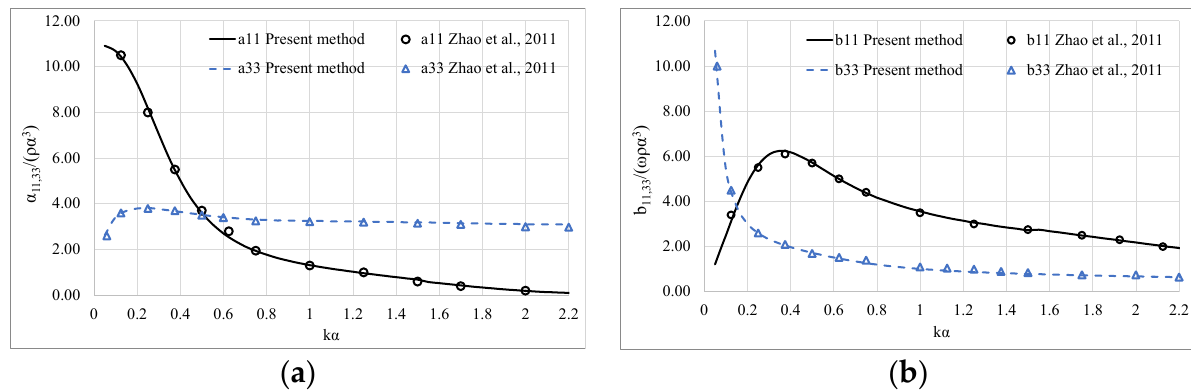
Figure 3. Comparison of the present method results against those due to Zhao et al. [32], concerning the hydrodynamic coefficients of a porous cylinder: ( a ) hydrodynamic added mass in surge and heave; ( b ) hydrodynamic damping coefficients in surge and heave. The drift forces on a floating porous cylinder (i.e., b = 0) are also presented. For comparisons, the results reported in study [61] are exploited. The examined cylinder of radius α and draught ( d − h 1 )/ α = 1, is floating at water depth d = 3 α . The thickness of